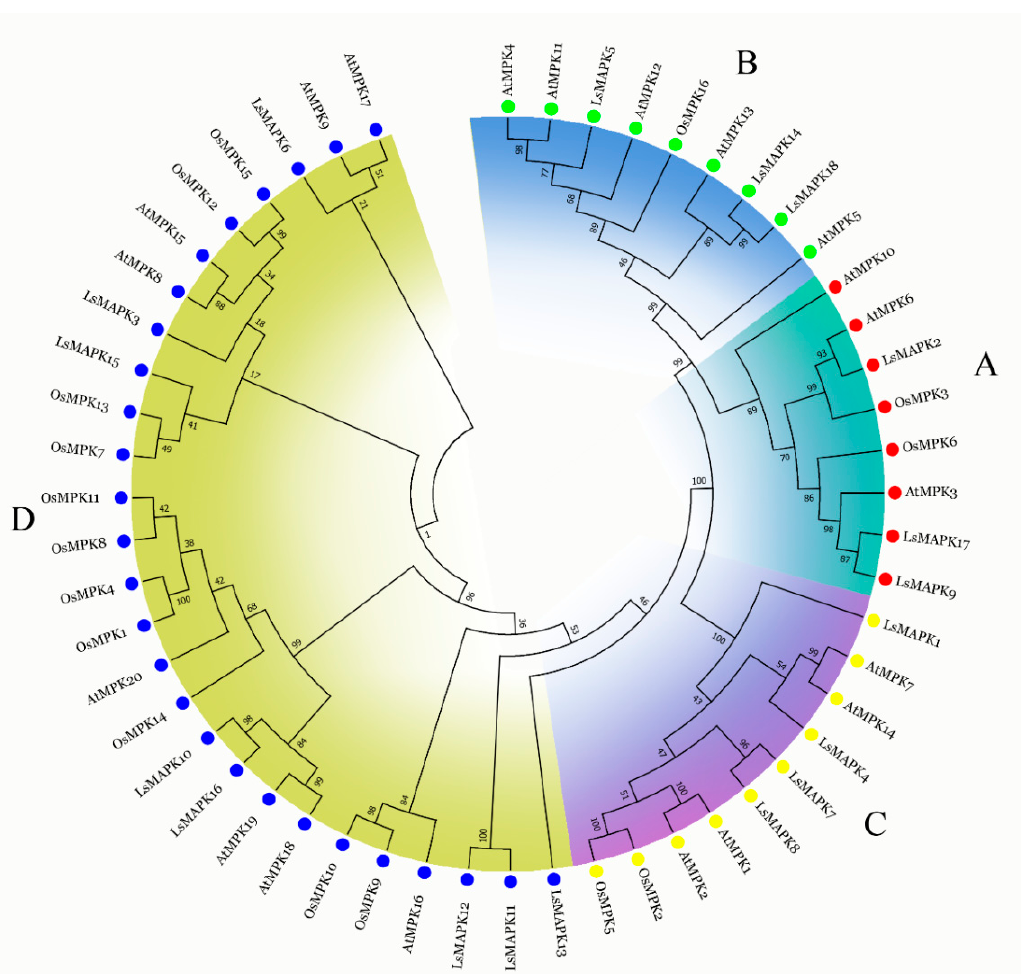
Figure 1. Phylogenetic tree of MAPK proteins among lettuce, Arabidopsis, and rice. MAPK proteins were divided into four subfamilies (A, B, C, and D), with each color group representing a